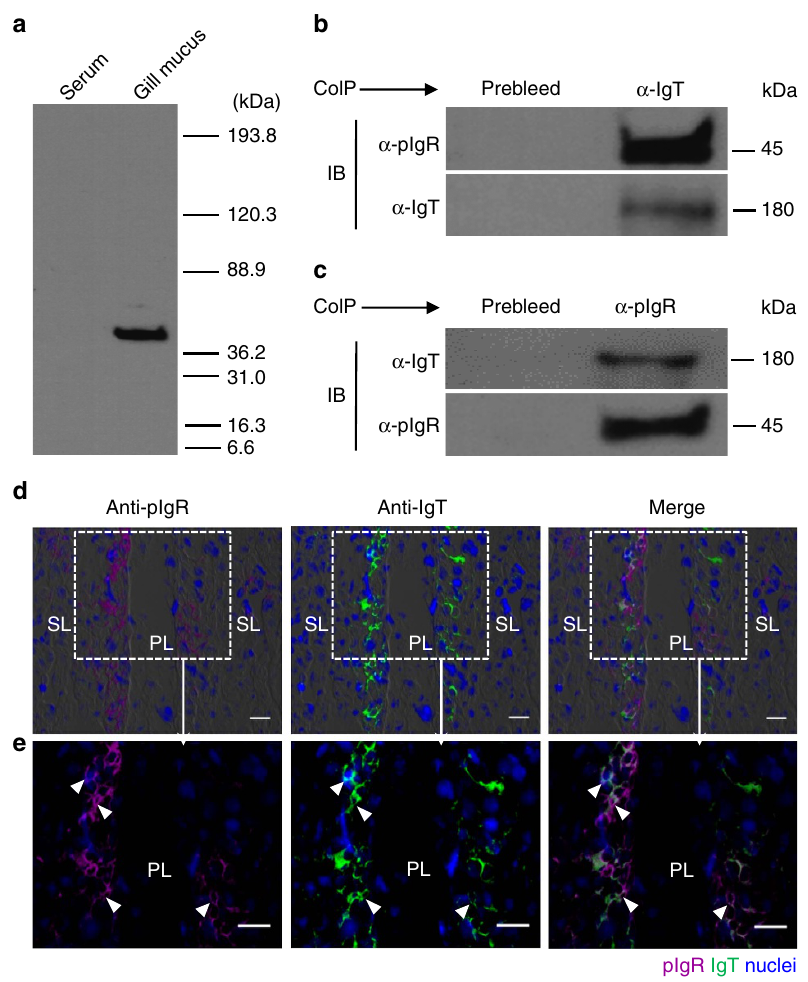
Figure 8 | Trout pIgR associates with gill sIgs. ( a ) SDS–PAGE under reducing conditions of trout serum and gill mucus ( B 5 m g each), followed by immunoblot analysis using anti-trout pIgR antibody. ( b ) Co-immunoprecipitation (CoIP) of gill mucus with anti-trout IgTantibody, followed by immunoblot analysis (IB) under reducing conditions (pIgR detection, upper panels) or non-reducing conditions (IgTdetection, lower panels). ( c ) CoIP of gill mucus with rabbit anti-trout pIgR followed by IB under non-reducing conditions (IgT detection, upper panels) and reducing conditions (pIgR detection, lower panels). IgG purified from rabbit’s serum before immunization (Pre-bleed) served as negative control for rabbit anti-trout pIgR and rabbit anti- trout IgT, respectively (left lane on each panel for b , c ). ( d ) Immunofluorescence staining for pIgR with IgT in gill cryosections of rainbow trout. Differential interference contrast images of gill cryosections were stained with anti-trout pIgR (magenta), anti-trout IgT (green) and DAPI for nuclei (blue) ( n ¼ 9). (isotype-matched control antibodies for anti-pIgR in Supplementary Fig. 4c online) ( e ) Enlarged sections of the areas outlined in d without DIC showing some pIgR/IgTcolocalization (white arrowhead). Scale bars, 20 m m. Primary lamellae (PL) and secondary lamellae (SL) are shown. Data are representative of at least three independent